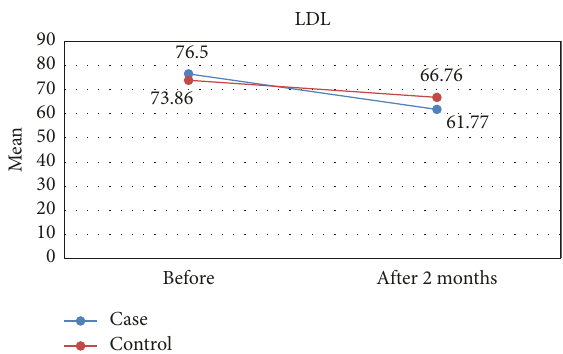
Figure 5: Effect of lycopene supplementation on LDL-C levels.